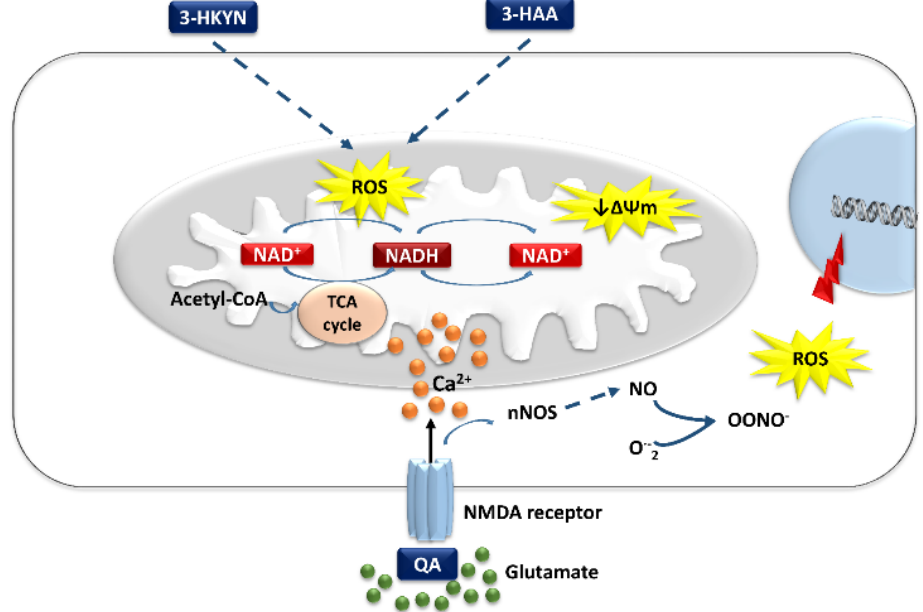
Figure 3. The involvement of 3-hydroxykynurenine, 3-hydroxyanthranilic acid, and quinolinic acid in the development of oxidative damages in the central nervous system cells. 3-HAA: 3-hydroxyanthranilic acid 3,4-dioxygenase, 3-HKYN: 3-hydroxykynurenine, acetyl-CoA: acetyl coenzyme A; Ca 2+ : calcium, NAD + : oxidized form of nicotinamide adenine dinucleotide, NADH: reduced form of nicotinamide adenine dinucleotide, NMDA: N-methyl-D-aspartate, nNOS: neuronal nitric oxide synthases, NO: nitric oxide, O 2• − : superoxide, OONO - : peroxynitrite, QA: quinolinic acid, ROS: reactive oxygen species, TCA cycle: tricarboxylic acid cycle, Ψ m: the mitochondrial membrane potential.